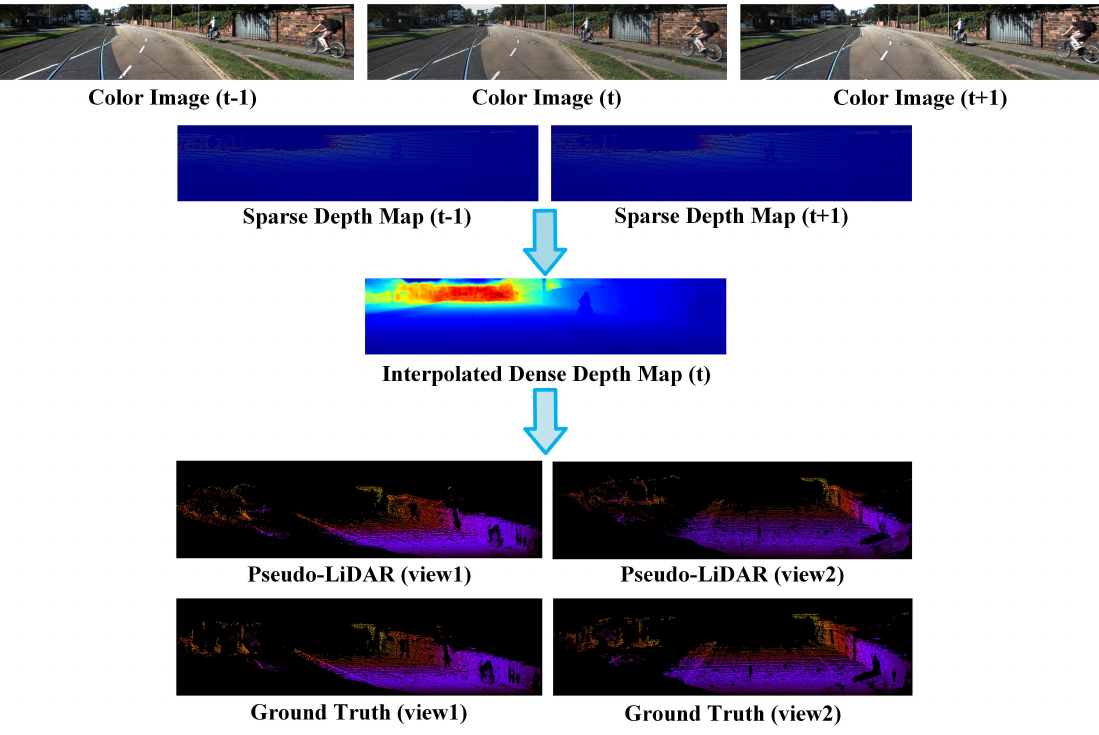
Figure 1. Overall pipeline of the proposed method. PLIN aims to address the mismatching problem of frequency between camera and LiDAR sensors, generating both temporally and spatially high-quality point cloud sequences. Our method takes three consecutive color images and two sparse depth maps as inputs, and interpolates an intermediate dense depth map, which is further transformed into a Pseudo-LiDAR point cloud using camera